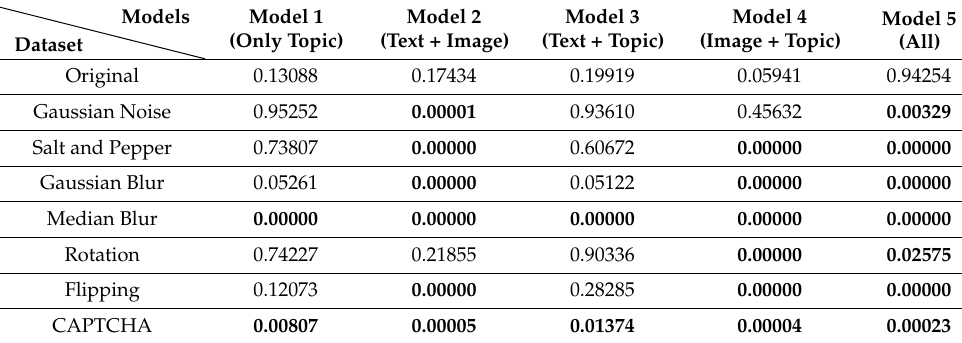
Table 13. p -values of the chi-square test with Baseline-1 on the ISH dataset.